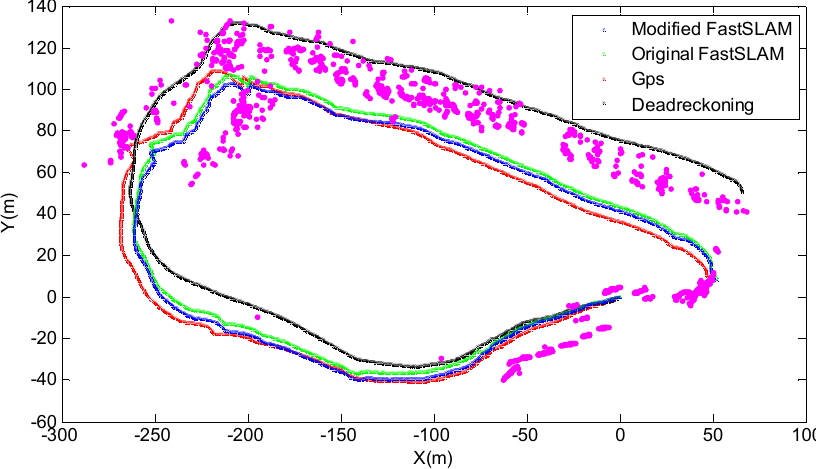
Figure 12 is a comparison of the trajectories for GPS, dead-reckoning, FastSLAM and the modified-FastSLAM algorithms obtained by averaging over 50 independent runs. Obviously, the deviation of original FastSLAM (the green line) relative to GPS is smaller than that of dead-reckoning (the black line) and greater than that of modified one (the blue line). Figure 12. Comparison of the trajectories for GPS, Dead-Reckoning, Original FastSLAM and Modified-SLAM by averaging over 50 independent